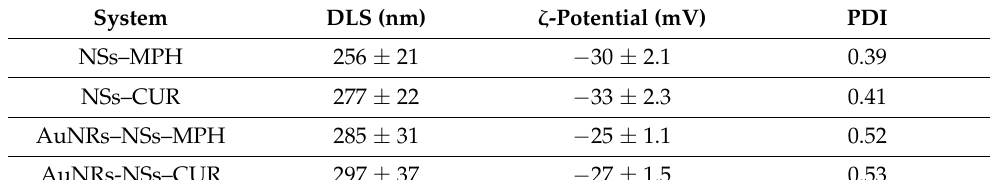
Table A1. DLS, ζ -potentials, and PDI values of NSs–drugs complexes and AuNRs–ICs.